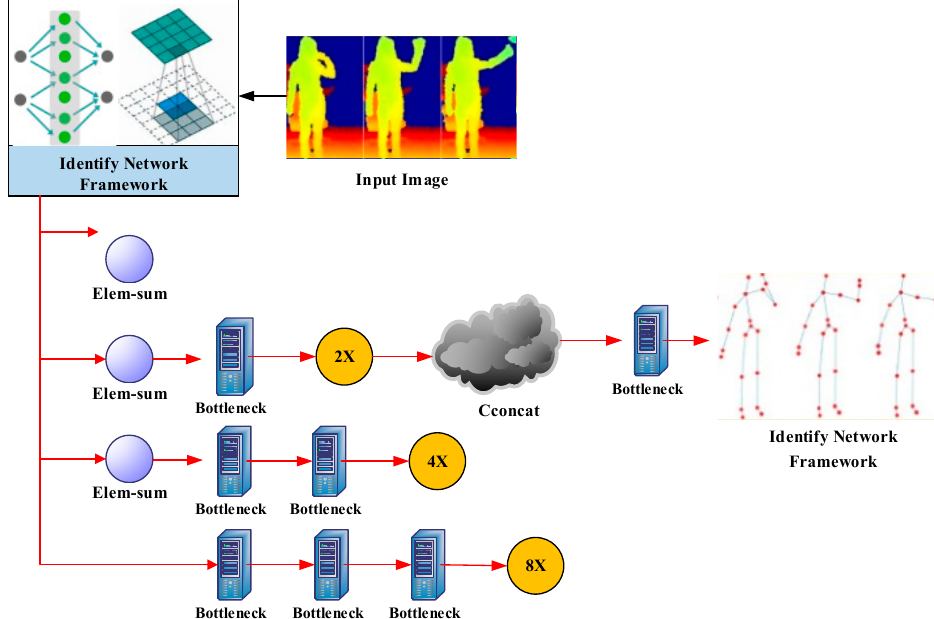
Figure 4. Principle of human posture estimation.